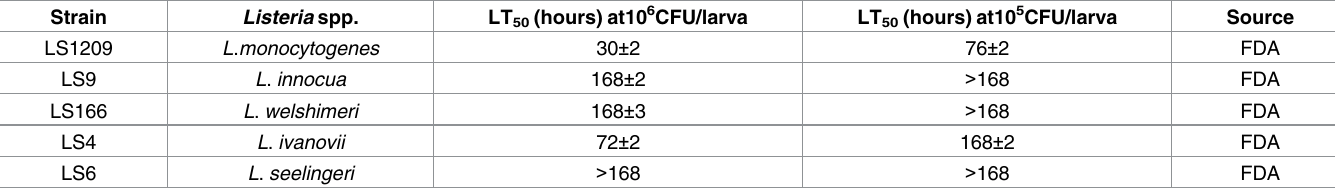
Table 1. LT 50 values for non-pathogenic and pathogenic Listeria spp. employed in this study * . Strain Listeria